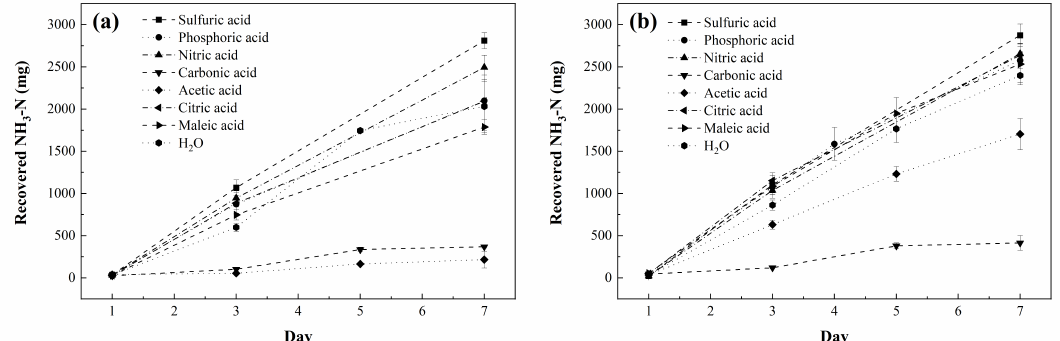
Figure 1. Evolution of the amount of TAN captured in the different trapping solutions during the 7-day experiments at ( a ) 25 ◦ C and ( b ) 2 ◦ C. All values are expressed as mean ± s.d. of n = 3.